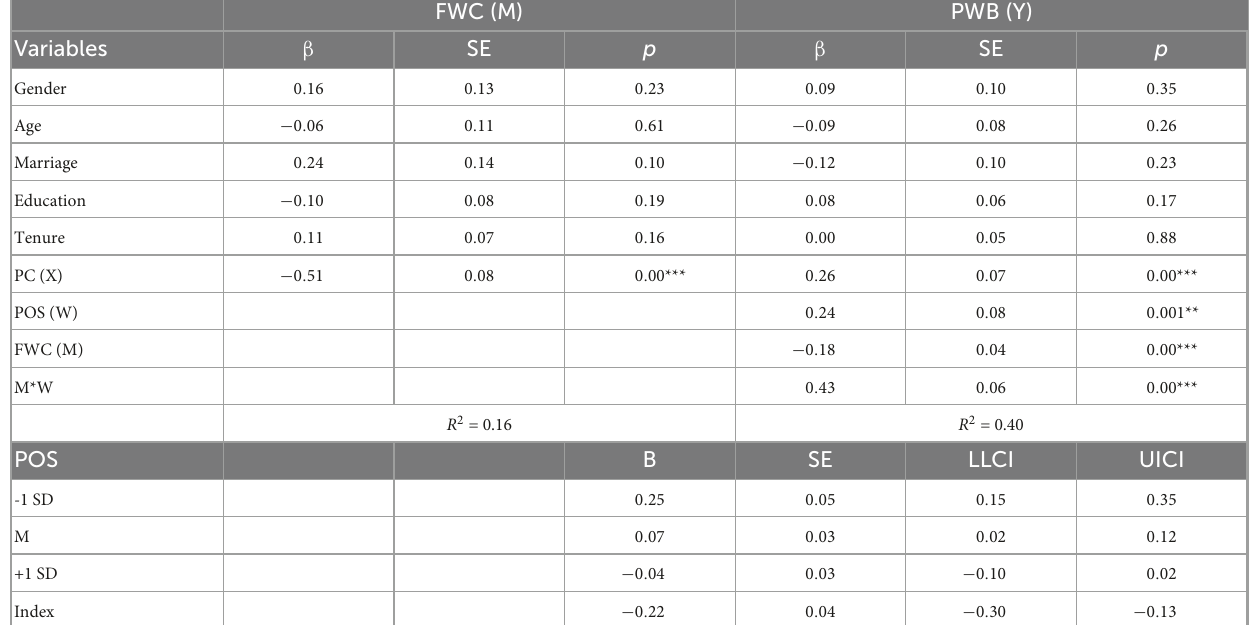
TABLE 6 Results of moderated-mediation of FWC.